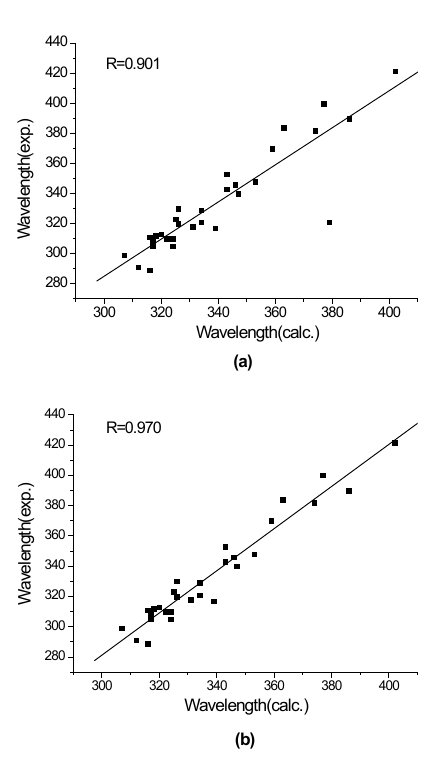
Figure 2. The relationship between experimental and theoretical λ for chalcones with (a) and without (b)